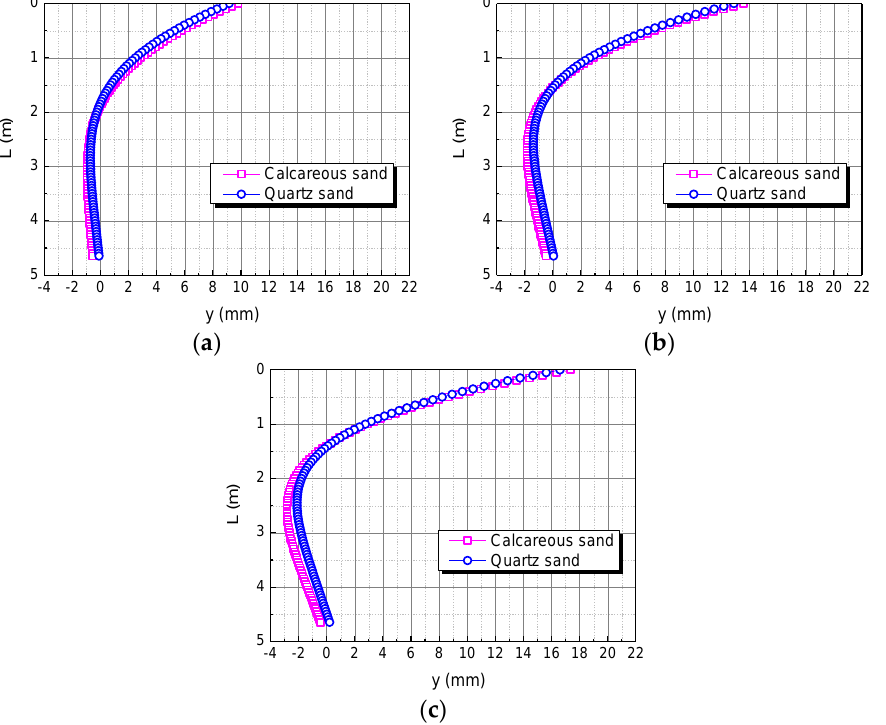
Figure 15. Effect of horizontal load on horizontal displacement of pile. ( a ) H; ( b ) 2H; ( c ) 3H.